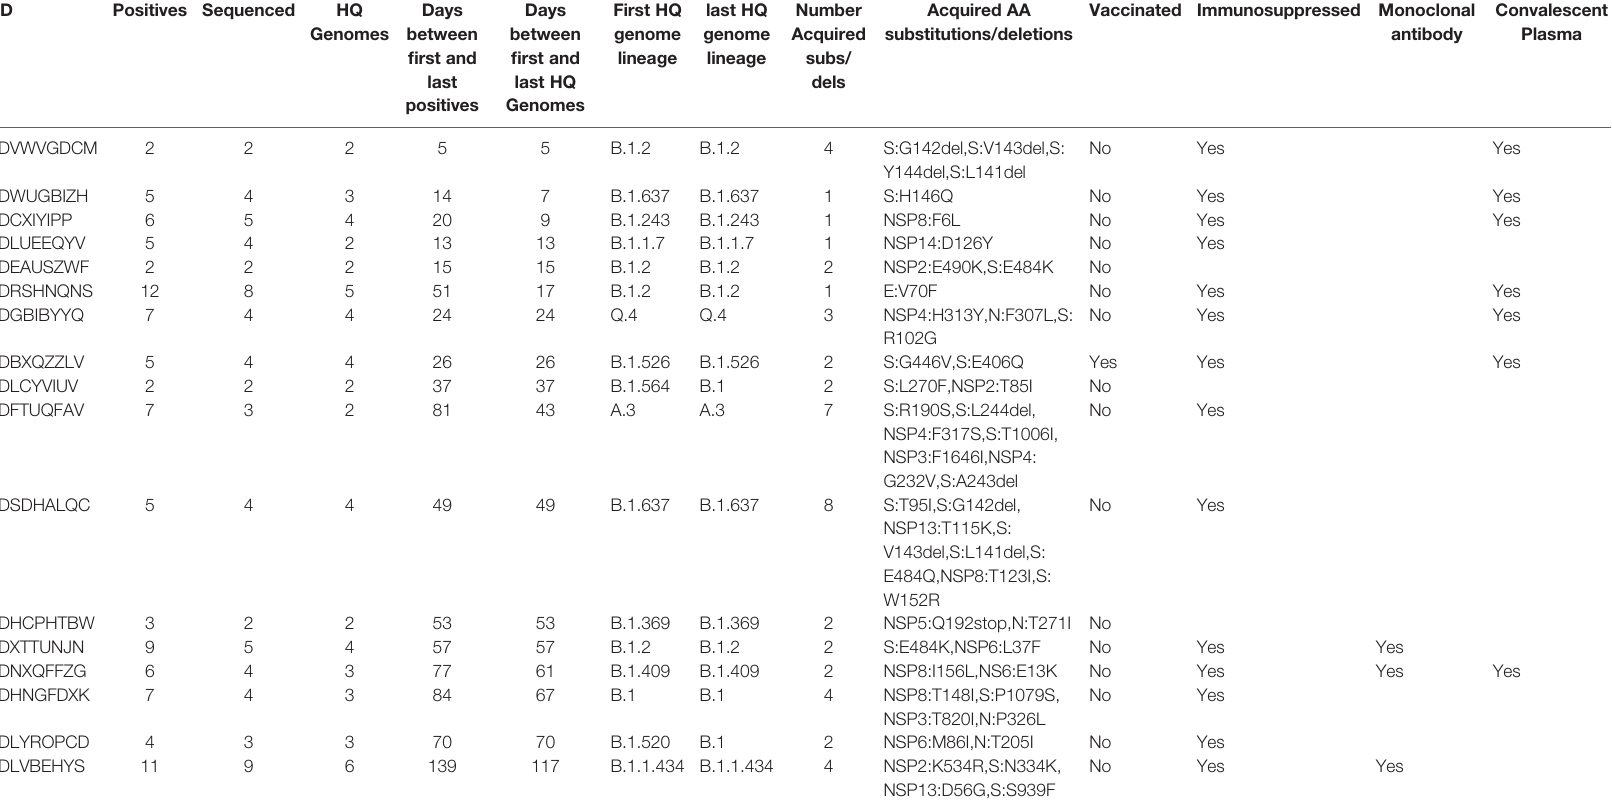
TABLE 3 | Prolonged viral shedding and genomic